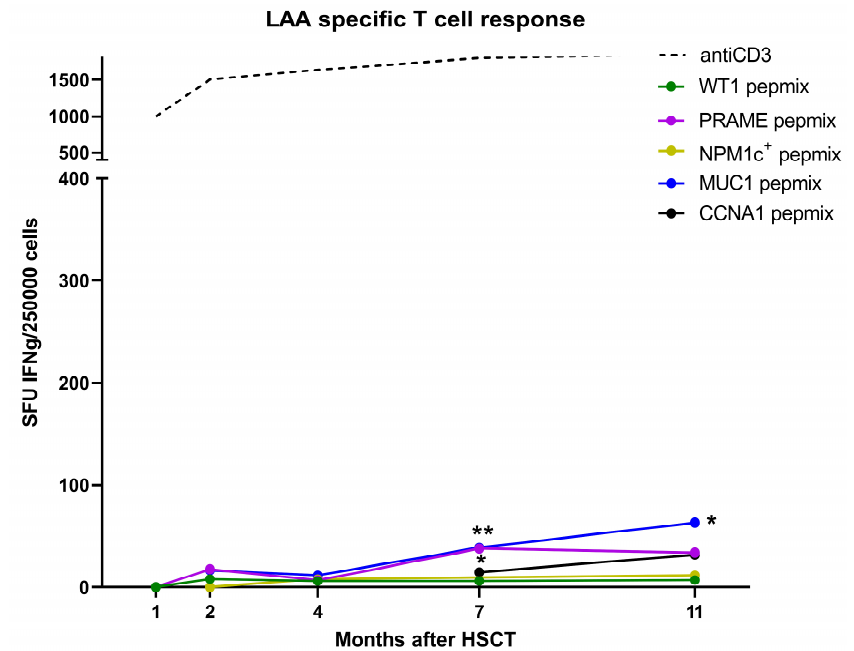
Figure 2. Monitoring of LAA-specific T cell responses in an AML patient after HSCT. Frequency of SFU specific for Wilm ´ s tumor antigen (WT-1), PRAME, mutated NPM1c + , mucin (MUC-1)